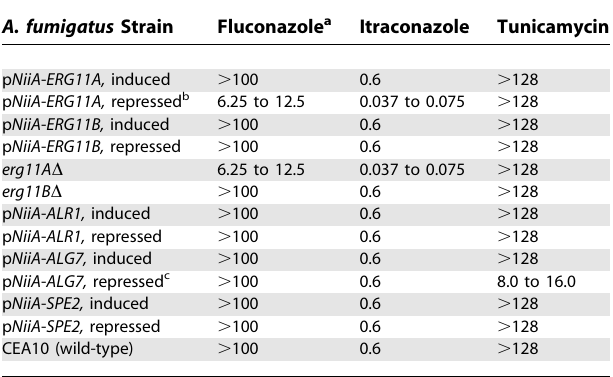
Table 3. MIC of Antifungal Drugs to p NiiA -CPR